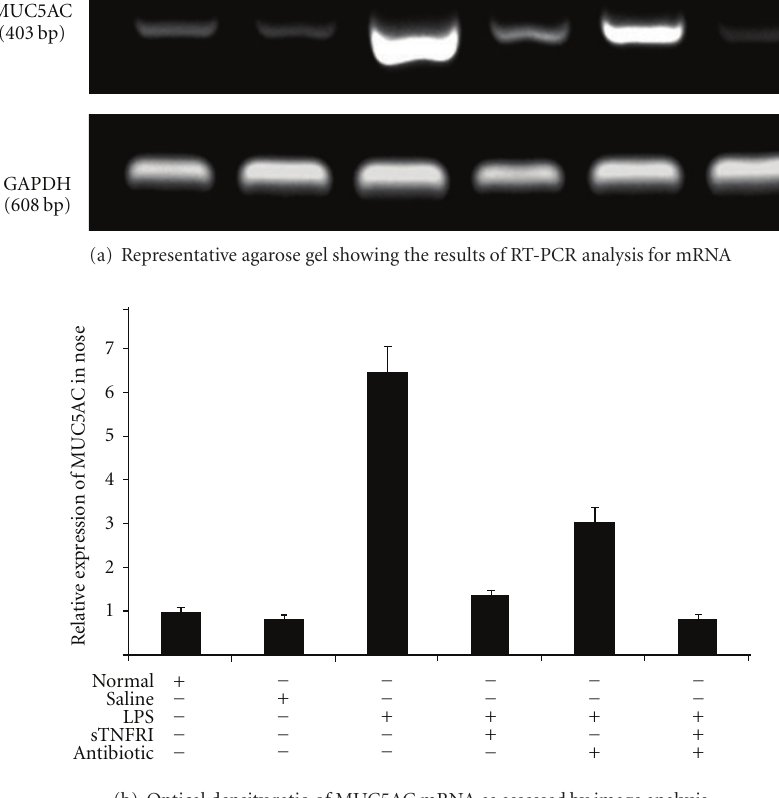
(b) Optical density ratio of MUC5AC mRNA as assessed by image analysis Figure 5: Expression of MUC5AC mRNA in the rat nose on the 4th day after the final instillation of LPS. The level of MUC5AC mRNA expression was significantly higher in rats treated with LPS, and upregulation of MUC5AC mRNA expression was inhibited by sTNFRI, antibiotic, and sTNFRI/antibiotic ( P < .